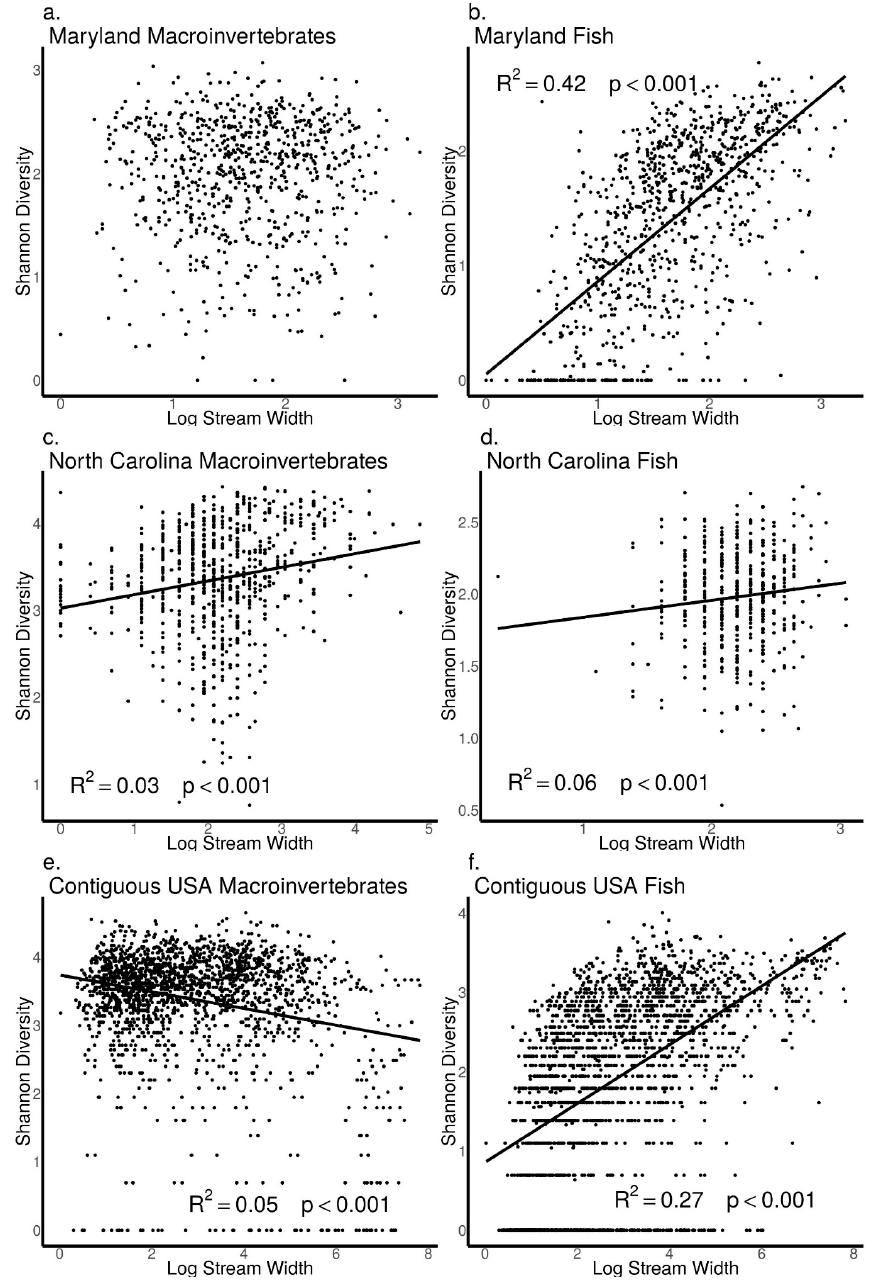
Figure 10. Relationship between Shannon diversity and stream width (log+1 transformed) for macroinvertebrate ( a , c , e ) and fish ( b , d , f ) communities collected from Maryland (MBSS), North Carolina (NCBMP) and contiguous USA (USEPA). Lines, R 2 and p -values indicate significant positive relationships determined by linear models.